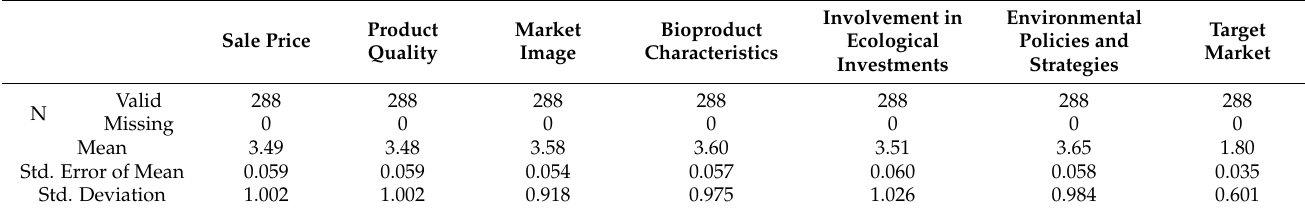
Table 4. Assessing the dispersion of responses for each domain.